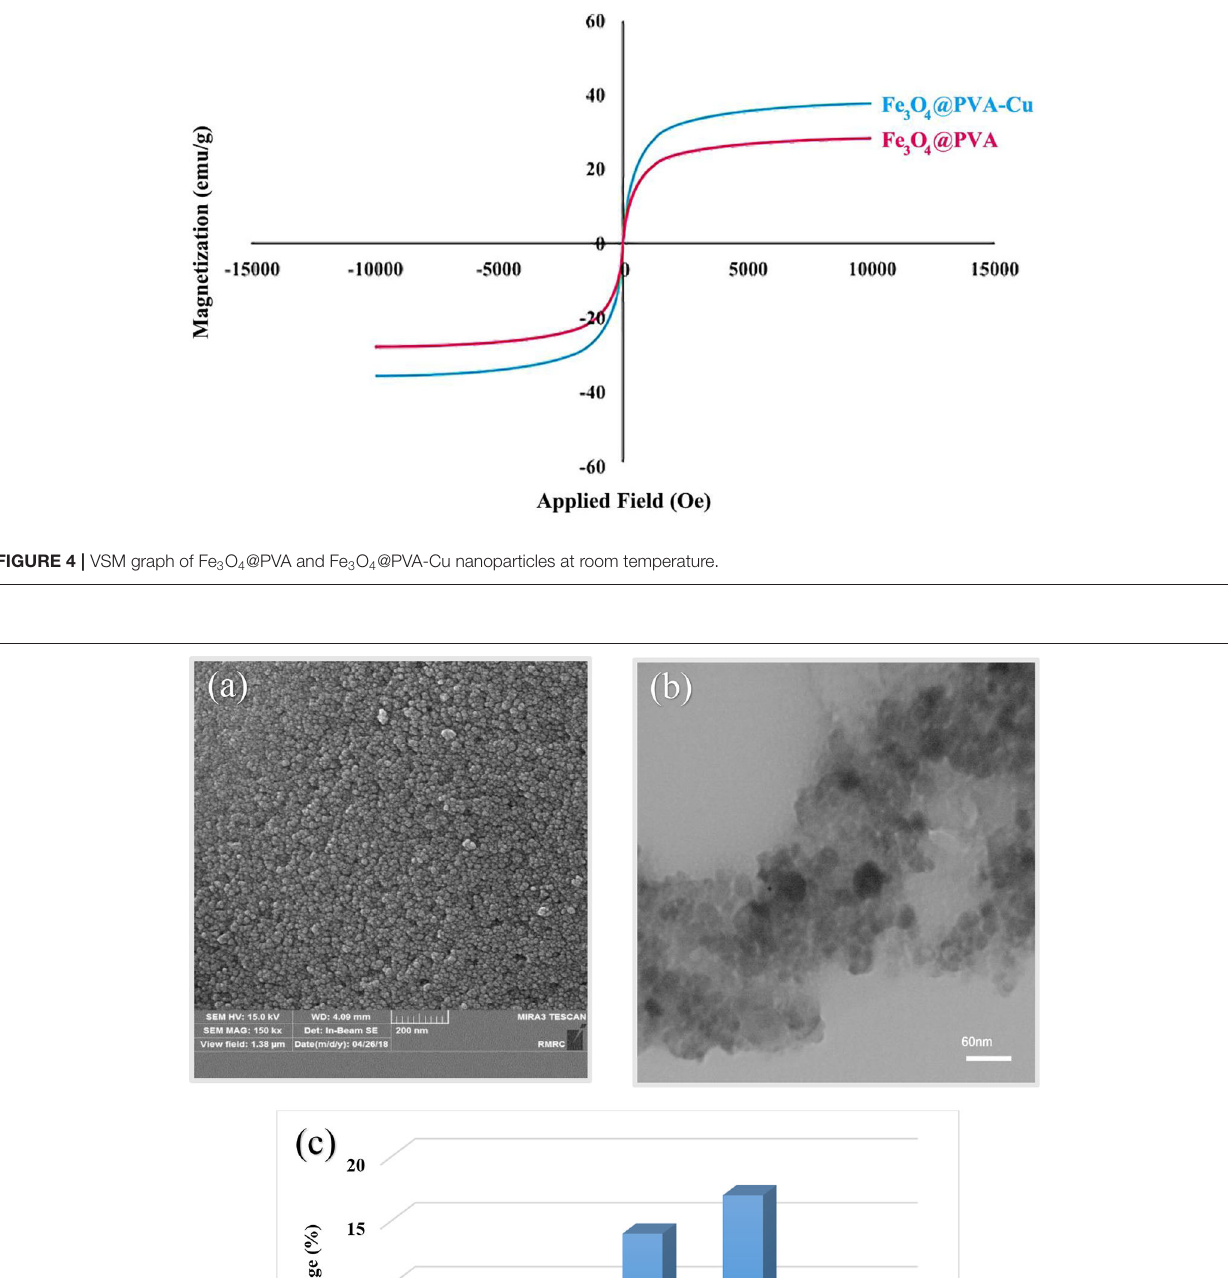
Frontiers in Chemistry |